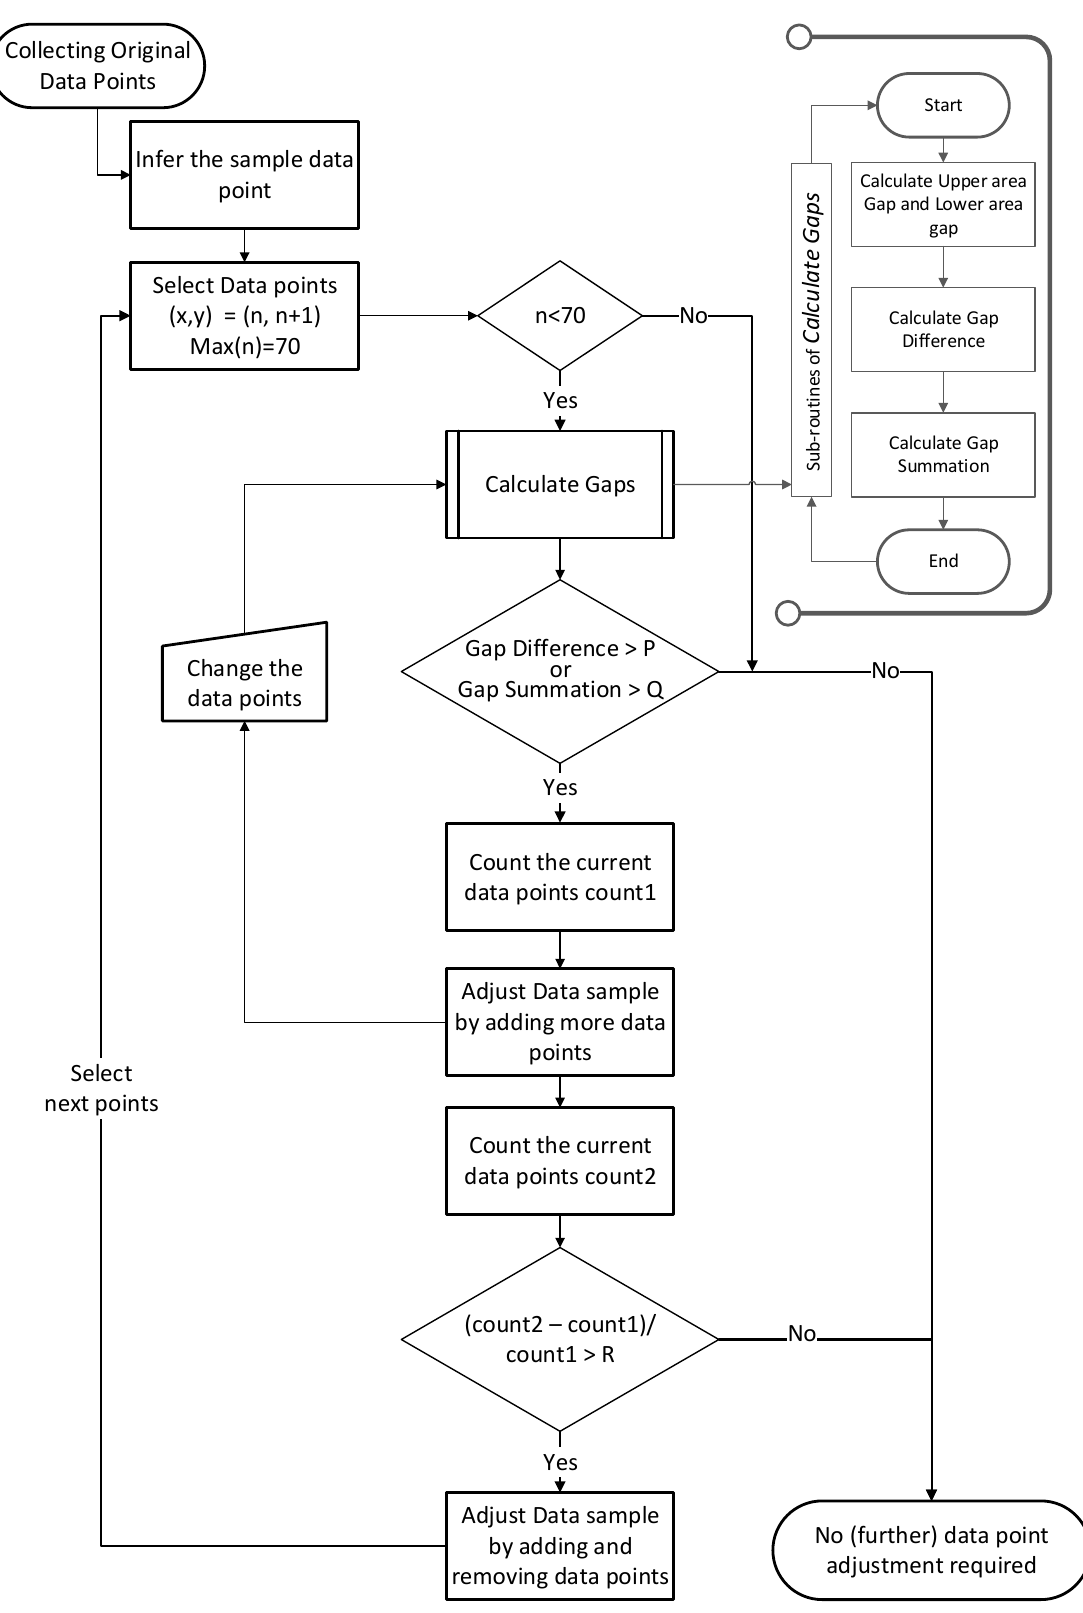
Figure 3. Workflow of adjusting data sampling flowchart.